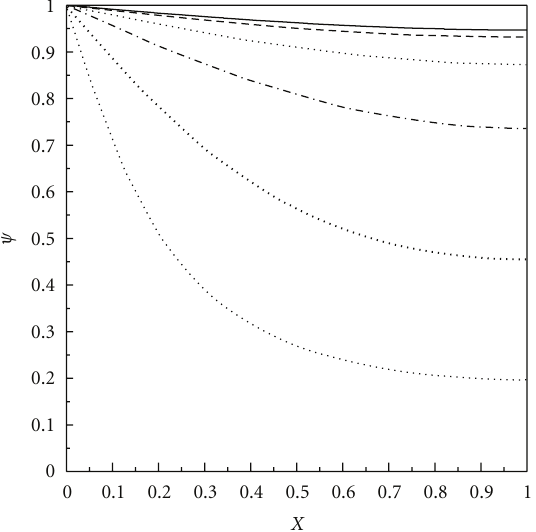
Figure 11: The distribution of dimensionless overpotential at particular X coordinates of the catalyst layer T = 333K, c 0 l = 10 μ m, a = 1 . 0 × 10 5 m − 1 , E 0 = 0 . 4V, κ e = 3 . 4 Ω − 1 m − 1 , D e = 3 . 04 × 10 − 10 m 2 s − 1 , lines A-A (cid:2) to F-F (cid:2) are from up to